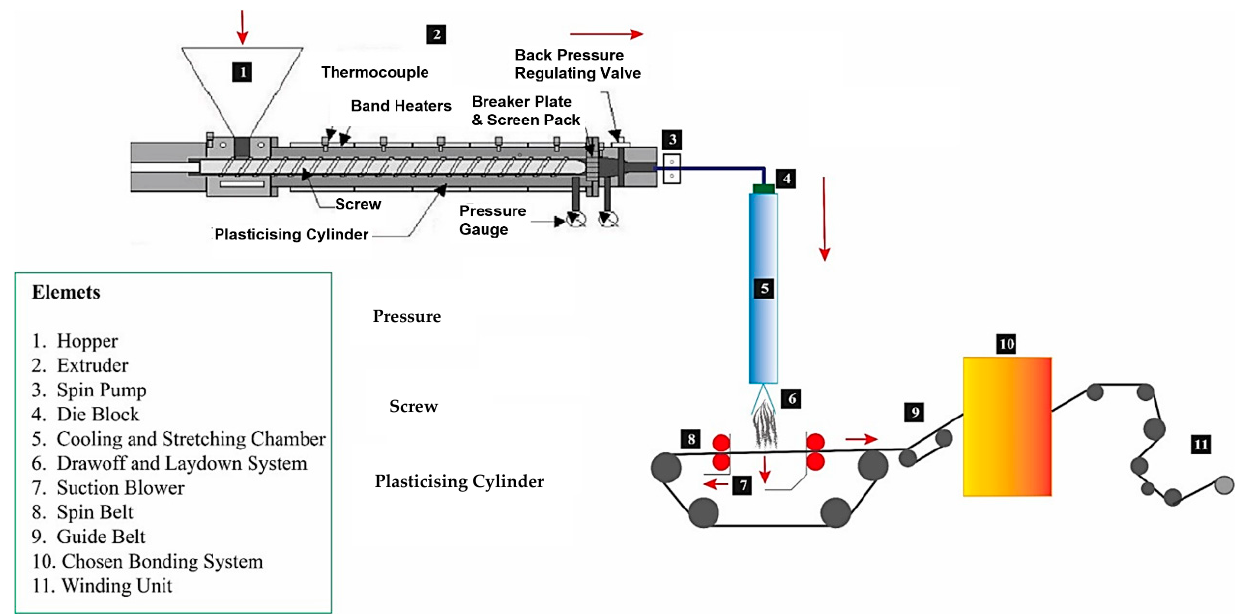
Figure 5. Schematic spunlaid process [36].